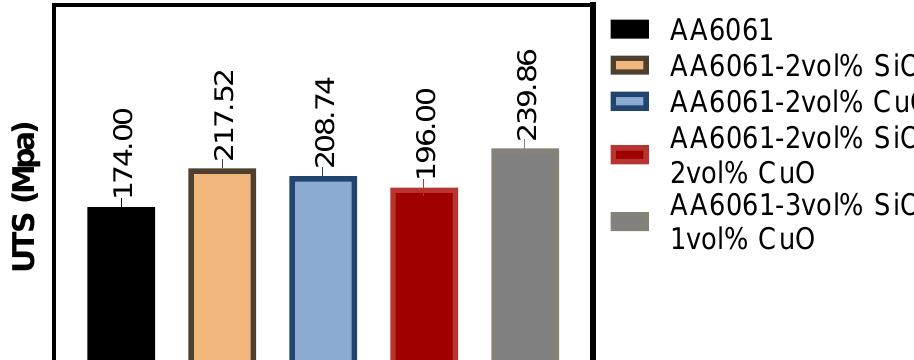
Figure 2. UTS of various composite samples.